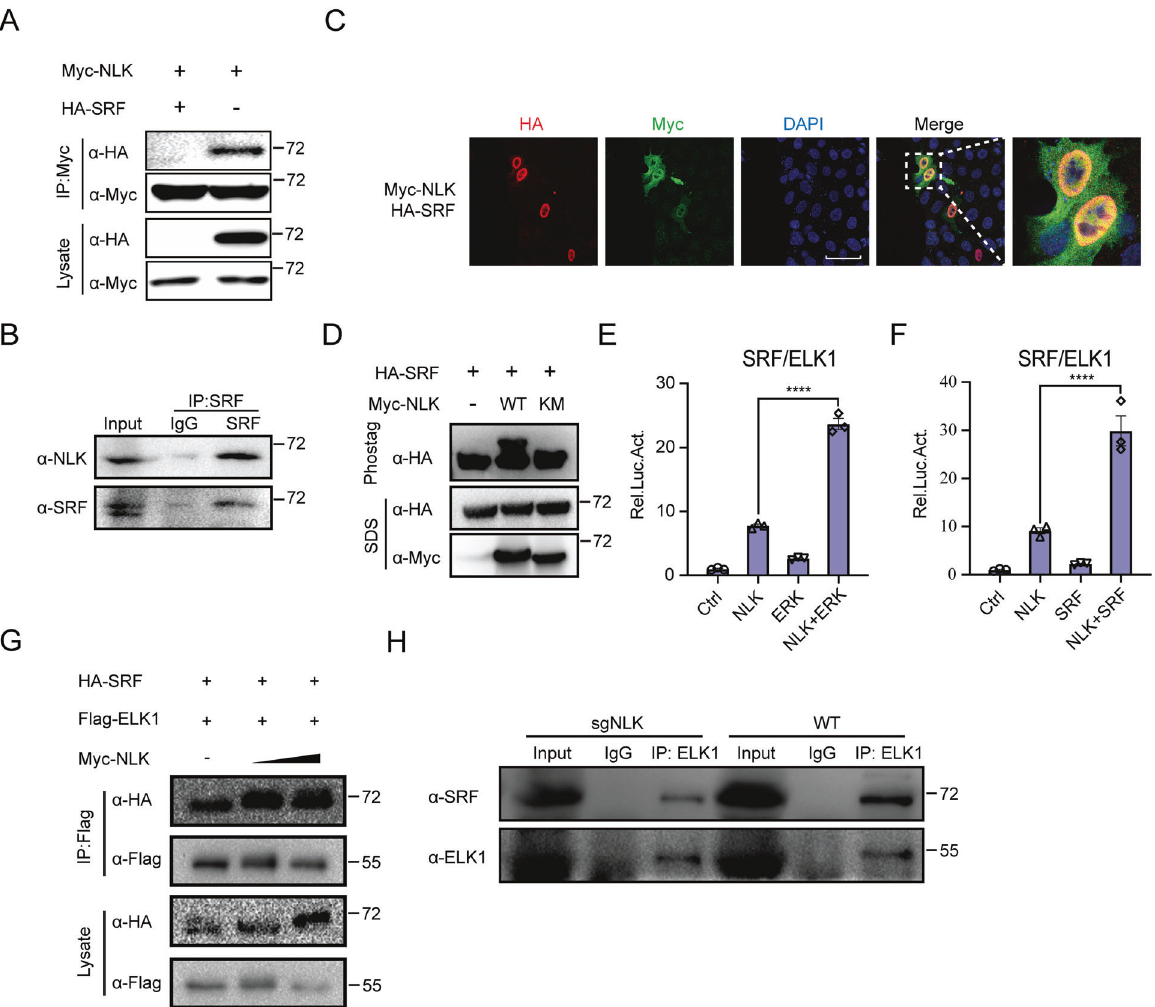
Fig. 4 NLK enhanced the interaction between SRF and ELK by phosphorylating SRF. A Exogenous coimmunoprecipitation analysis showing the interaction between NLK and SRF. HEK293T cells were cotransfected with HA-SRF and Myc-NLK. Coimmunoprecipitation and immunoblotting were performed with the indicated antibodies. B Endogenous coimmunoprecipitation of C2C12 cell lysates performed with an anti-SRF antibody. Immunoblot analysis was performed with anti-NLK and anti-SRF antibodies. C Immuno fl uorescence analysis of the colocalization of exogenous NLK or NLK KM and SRF. Myc-NLK (green) and HA-SRF (red) were stained using anti-Myc and anti-HA antibodies. The nuclei were stained with DAPI (blue). Images were obtained by fl uorescence microscopy. Scale bar, 50 μ m. D Phos-tag TM SDS-PAGE showing the phosphorylation status of SRF in the presence of NLK or NLK KM in HEK293T cells. HA-SRF was cotransfected with Myc-NLK- or Myc-NLK KM -overexpression plasmids into HEK293T cells, which were lysed 36 h after transfection. Proteins were separated by SDS-PAGE containing Phos-tag TM and general SDS-PAGE with anti-HA and anti-Myc antibodies. The upper shifted band represents phosphorylated SRF protein. The bottom band represents the unphosphorylated form of SRF. E , F Luciferase assays showing the synergistic effects of NLK and ERK ( E ) or SRF ( F ) on SRF/ELK signaling in HEK293T cells. SRF/ELK reporter (100 ng) was cotransfected with the NLK and ERK or SRF plasmids (200 ng) into HEK293T cells for 36 h, followed by analysis with a luciferase kit assay ( n = 3). G Coimmunoprecipitation analysis showing the effects of NLK on the interaction between ELK1 and SRF. HEK293T cells were cotransfected with HA-SRF, Flag-ELK1, and Myc-NLK. Coimmunoprecipitation and immunoblotting were performed with the indicated antibodies. H Coimmunoprecipitation of endogenous proteins in wild-type and NLK-knockdown C2C12 cells performed with an anti-ELK1 antibody in the presence of TPA. Immunoblotting was performed with anti-ELK1 and anti-SRF antibodies. Data are representative of three independent experiments and presented as the mean ± SEM. Statistical signi fi cance was analyzed by ANOVA (**** p < 0.0001). Ctrl control, WT wild-type, KM NLK KM mutant. Source data ( A – H ) are provided as a source data fi